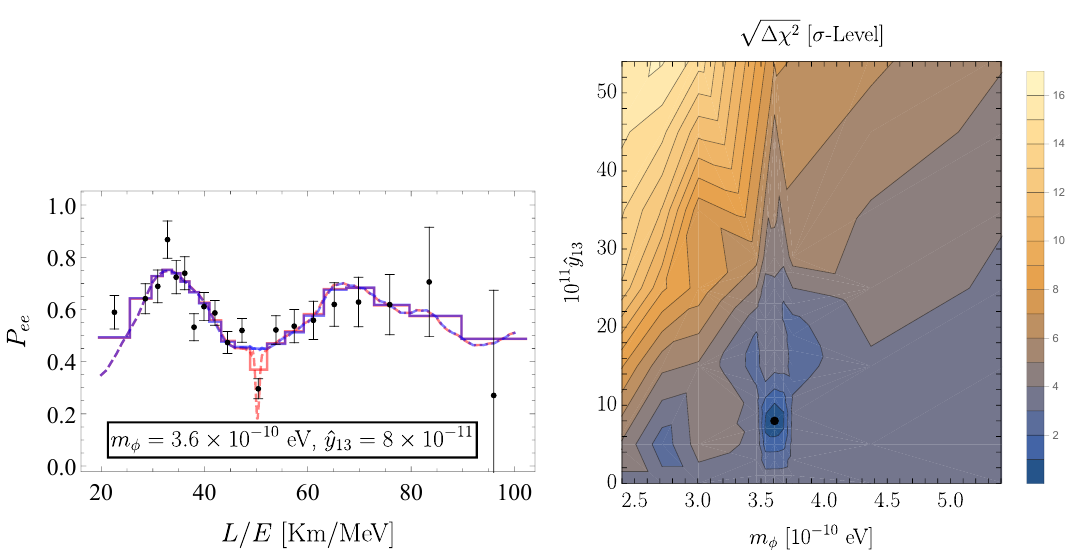
Figure 2 . The KamLAND experiment: (Left) P ee ( L/E ) : the experimental results (black), the best fit of standard oscillations in matter (blue), and the best fit for a ULDM field of m = φ 3 . 6 × 10 − 10 eV and ˆ y = 8 × 10 − 11 (red). Shown are both the binned (solid) and the unbinned 13 (dashed) probabilities. (Right) p ∆ χ 2 for a ULDM field of mass m , and coupling ˆ y , compared φ 13 to the minimum, which corresponds to m = 3 . 6 × 10 − 10 eV and ˆ y = 8 × 10 − 11 φ 13